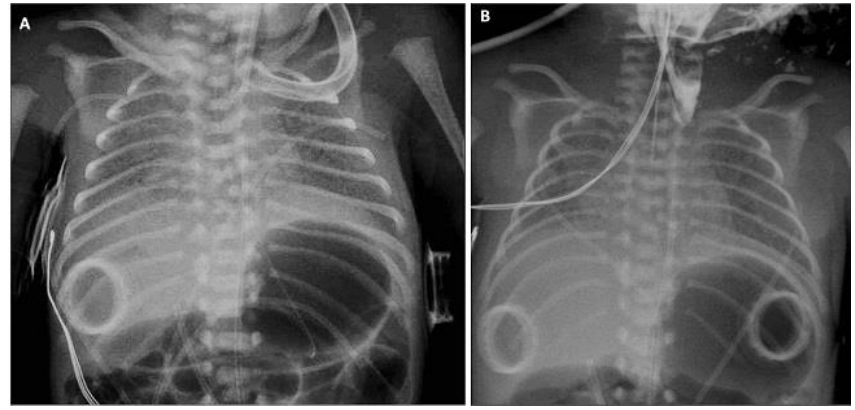
Figure 1: A) Nasogastric tube tip in stomach. B) Contrast study with proximal esophageal